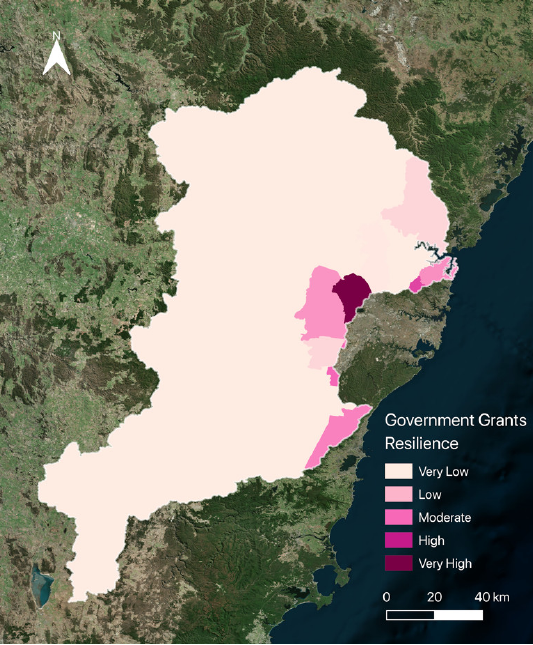
Figure 3. Government Grant Resilience after standardising using fuzzy membership processing. Resilience measured from Very Low (light pink) to Very High (dark pink).